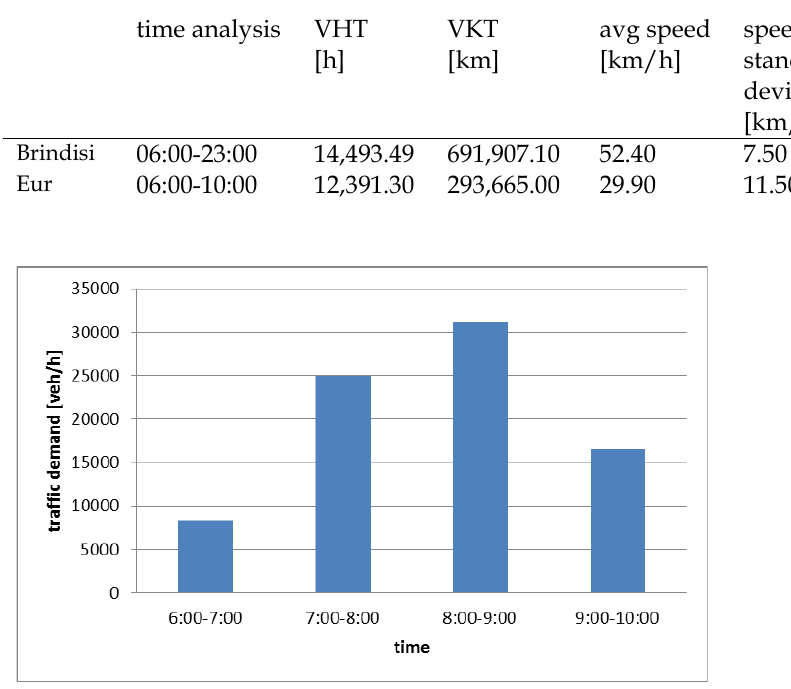
Table 2. Comparison between Brindisi and Eur network (network performances)